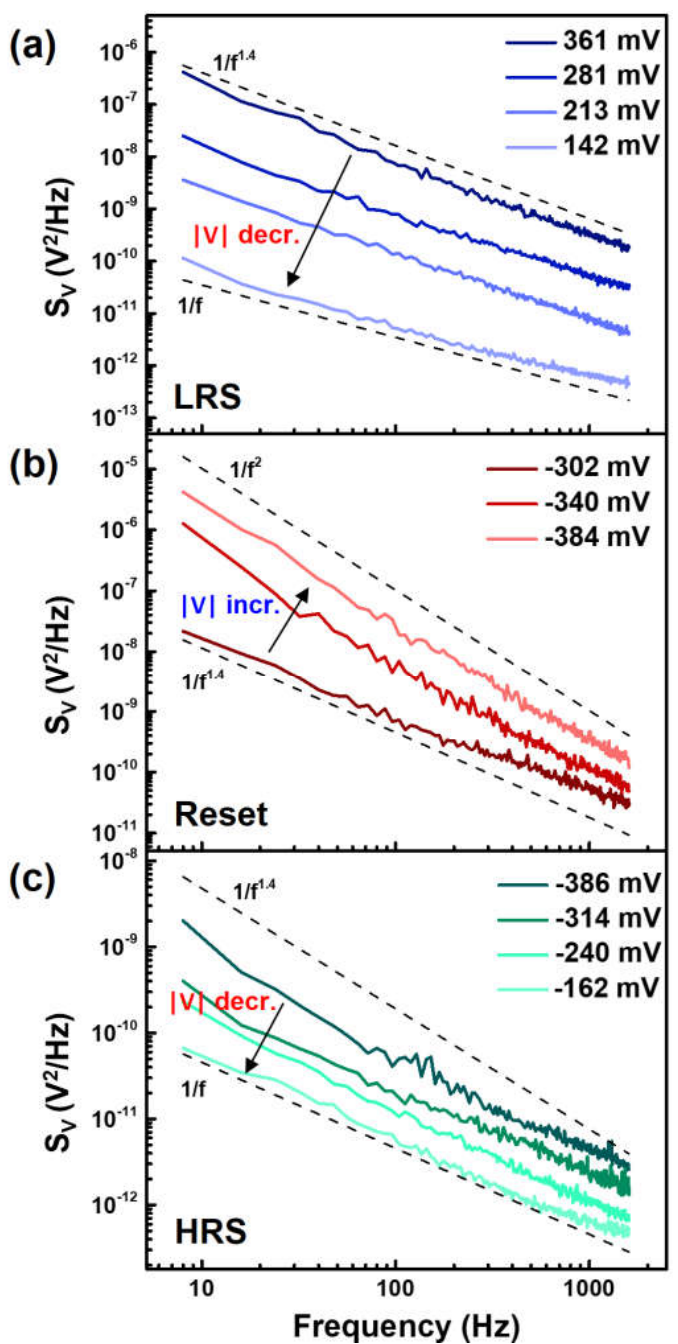
Figure 3. The PSD of the devices measured at the ( a ) LRS in step 2, ( b ) reset process in step 3, and ( c ) HRS in step 4. As the device underwent a transition from LRS to HRS in step 3, the exponent of 1/f increased dramatically from 1.4 to 2.0, which shows a significant discrepancy as compared to ( a ) and ( b ).